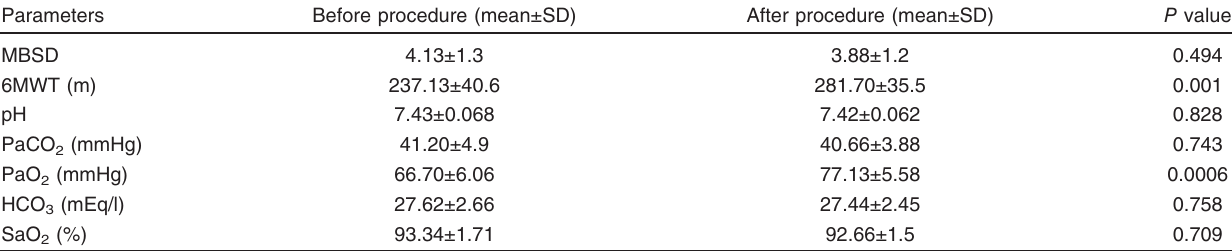
HCO 3 , bicarbonate; MBSD, Modified Borg scale of dyspnea; 6MWT, 6-min walk test; PaCO 2 , arterial partial pressure of carbon dioxide; PaO